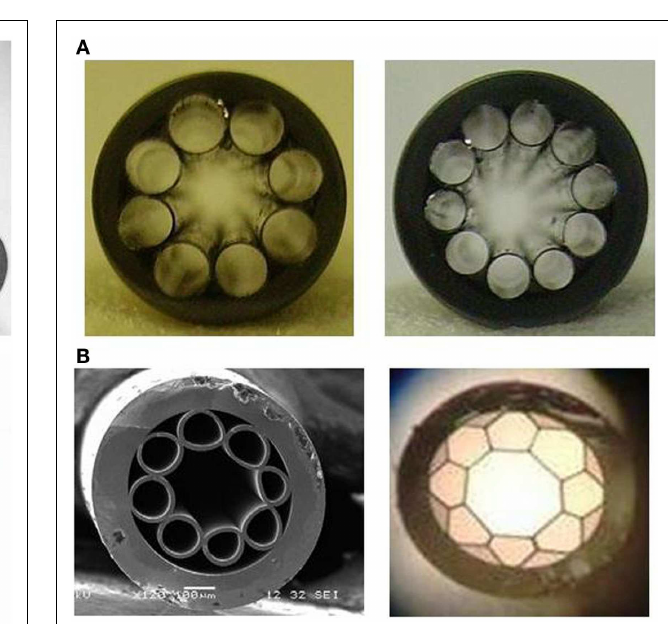
FIGURE 7 | (A) Substrate chalcogenide tubes; (B) HC-MOF performs (Shiryaev et al., 2014b).